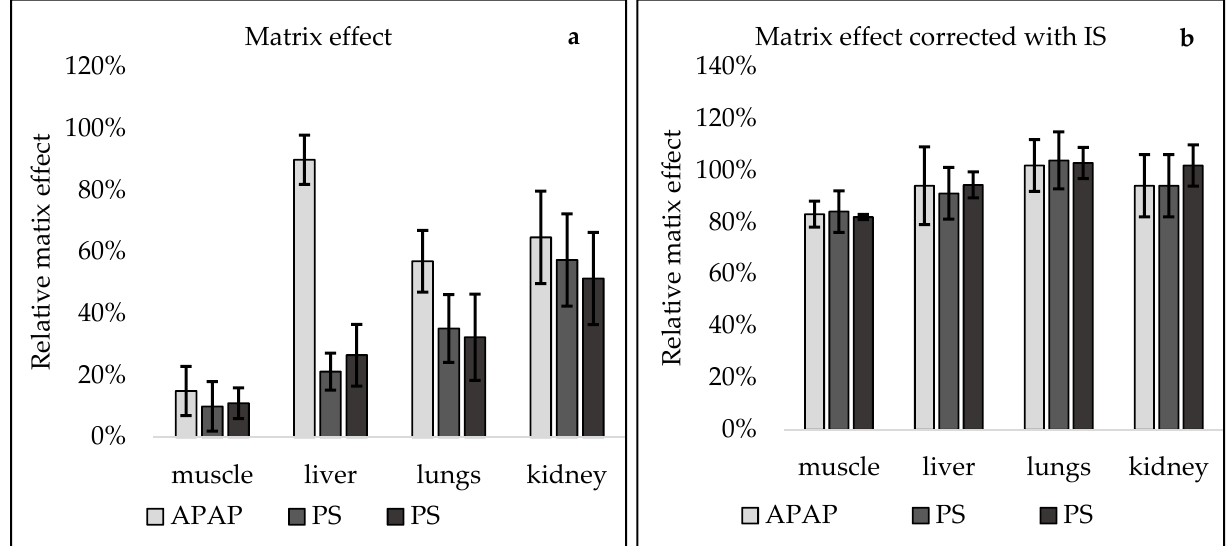
Figure 3. Matrix effect (mean ± SD, n = 20) in muscle, liver, lung, and kidneys samples: ( a ) without internal correction and ( b ) with internal correction.